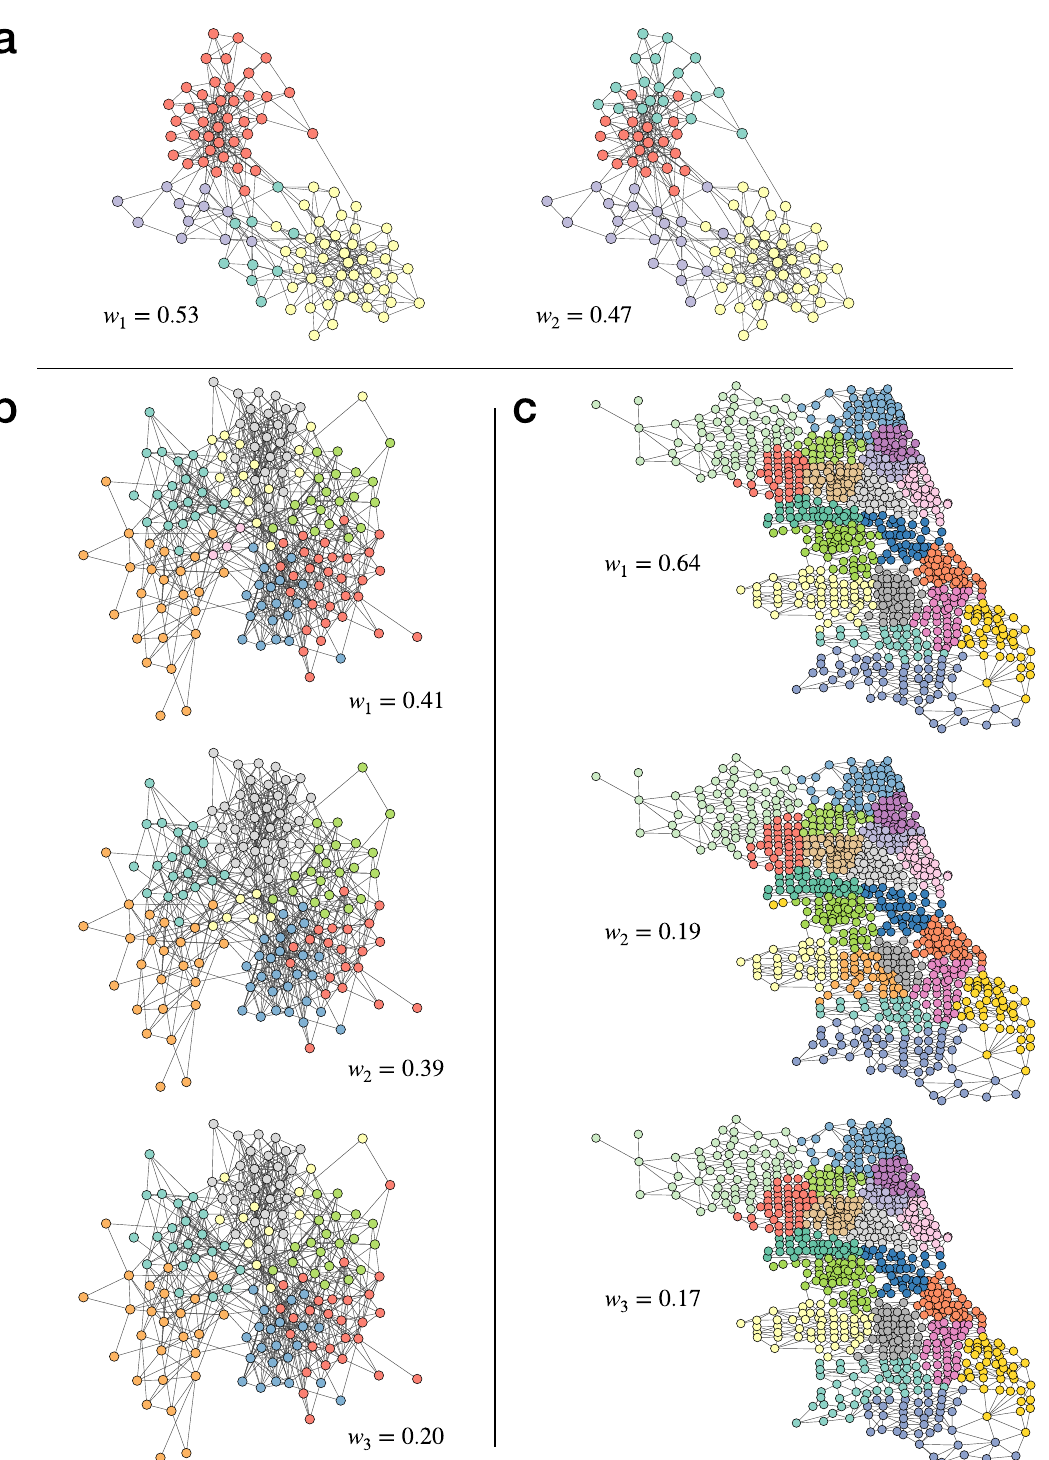
Fig. 3 Representative modes and their corresponding weights for three real-world example networks. a Network of political book co-purchases 37 . b High school friendship network 38,39 . c Network of adjacent census tracts in the city of Chicago 40 . Representative partitions are identi fi ed by minimizing Eq. (6) with penalty parameter λ = 1 for 10,000 community partition samples. The color of each node indicates its community membership within a partition, and w k is the weight of mode k